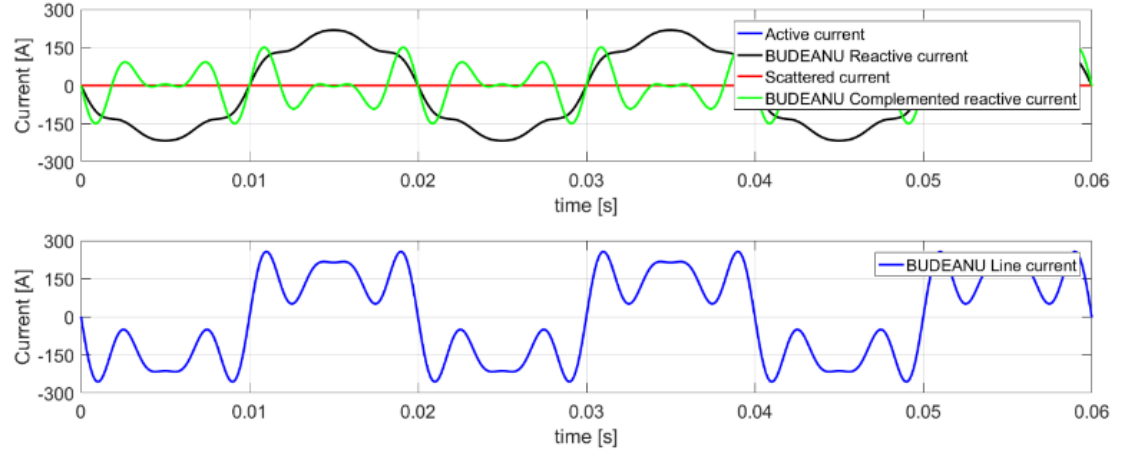
Figure 9. The waveform of the currents’ components and current of the load in development Budeanu’s theory.